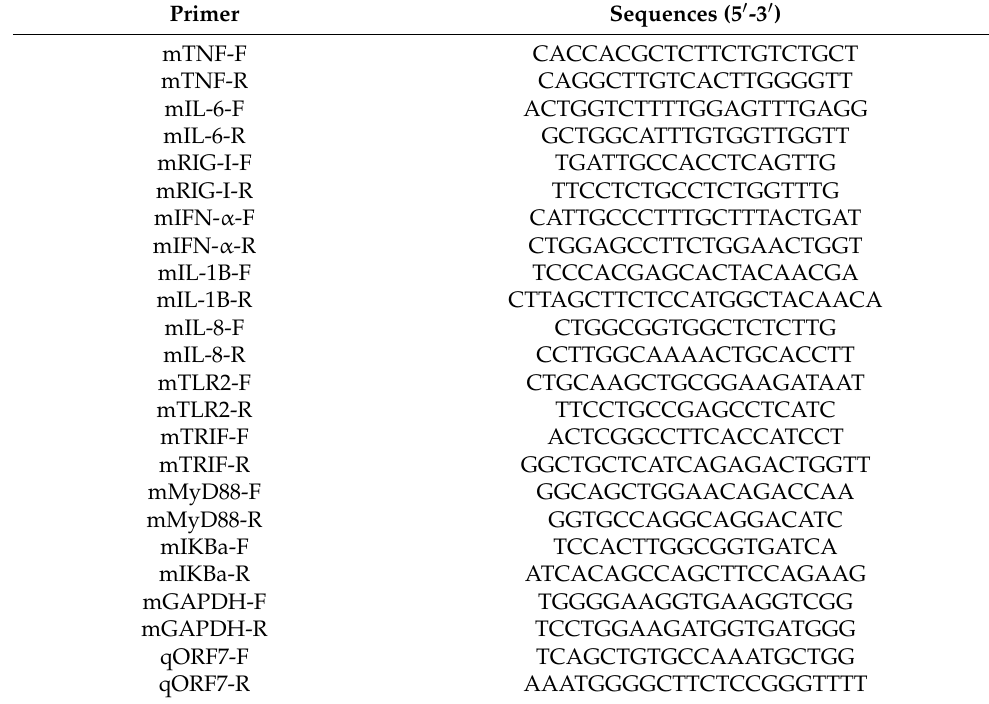
Table 2. Primer for mRNA quantitation used in